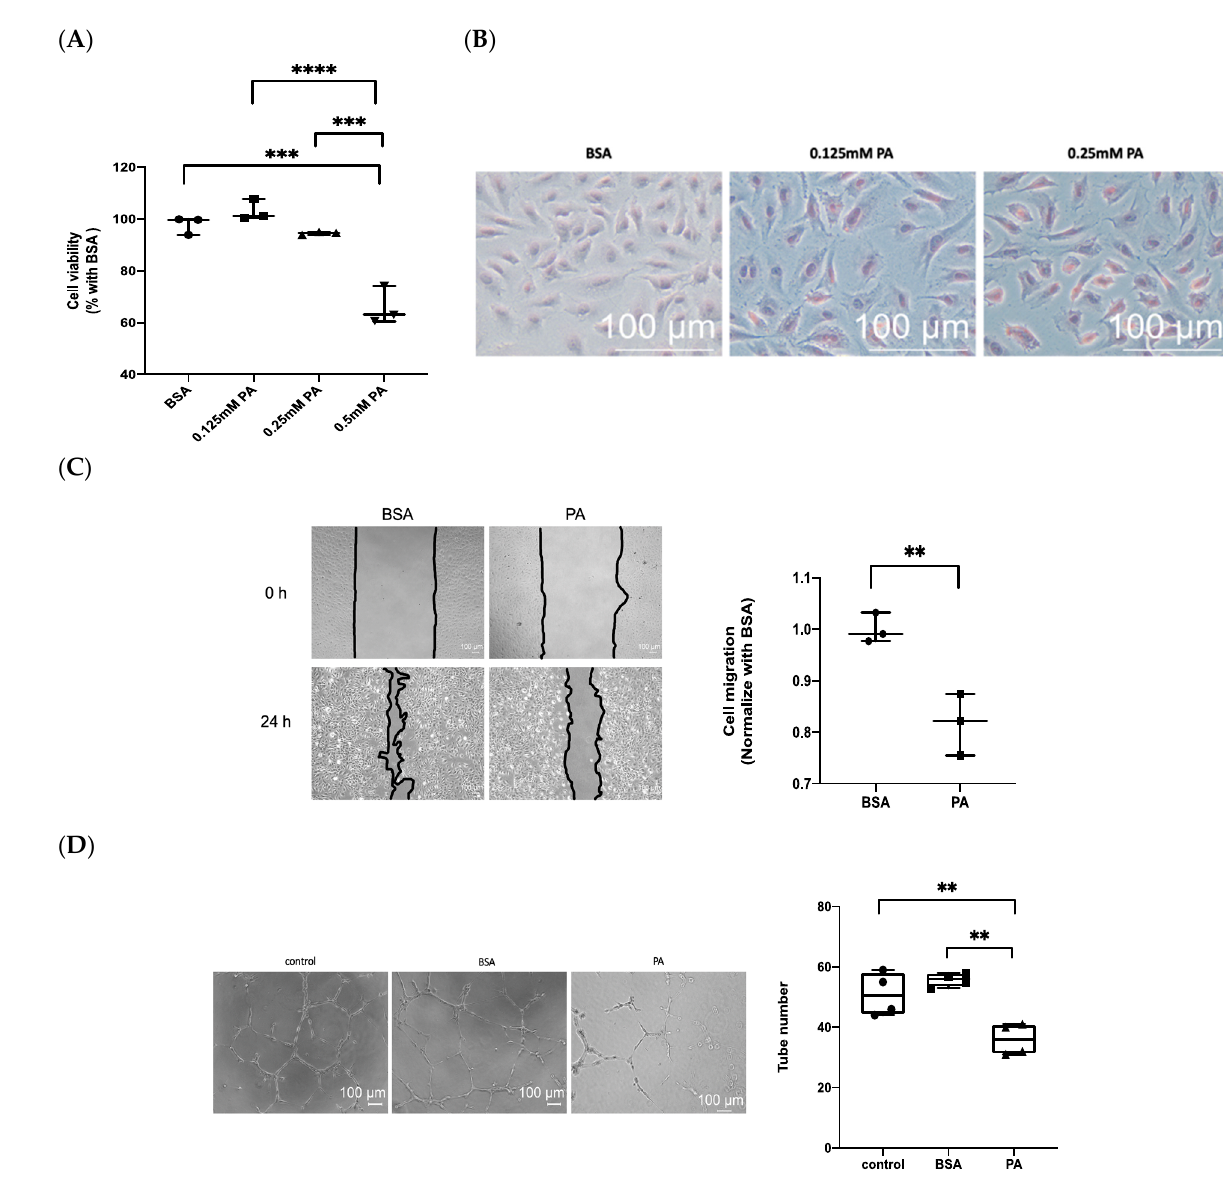
Figure 2. Palmitic acid (PA) treatment induces endothelial dysfunction in HUVECs. ( A ) The cytotoxic effects of PA on HUVECs were examined using the MTS assay. The HUVECs were treated with PA (0.125–0.5 mM) for 24 h; BSA was used as the control. ( B ) Intracellular lipid deposition was observed using oil red O (orange-red, scale bar: 100 μ m). ( C ) Wound healing assay was performed in the presence of BSA or PA and quantification. ( D ) The tube formation of endothelial cells (scale bar: 100 μ m) and quantification. Data are presented as the mean ± S.E.M of three independent experiments. Data from two groups were analyzed using the two-tailed Student’s t -test. Data from multiple groups were analyzed by one-way ANOVA, followed by Tukey’s multiple post hoc test.